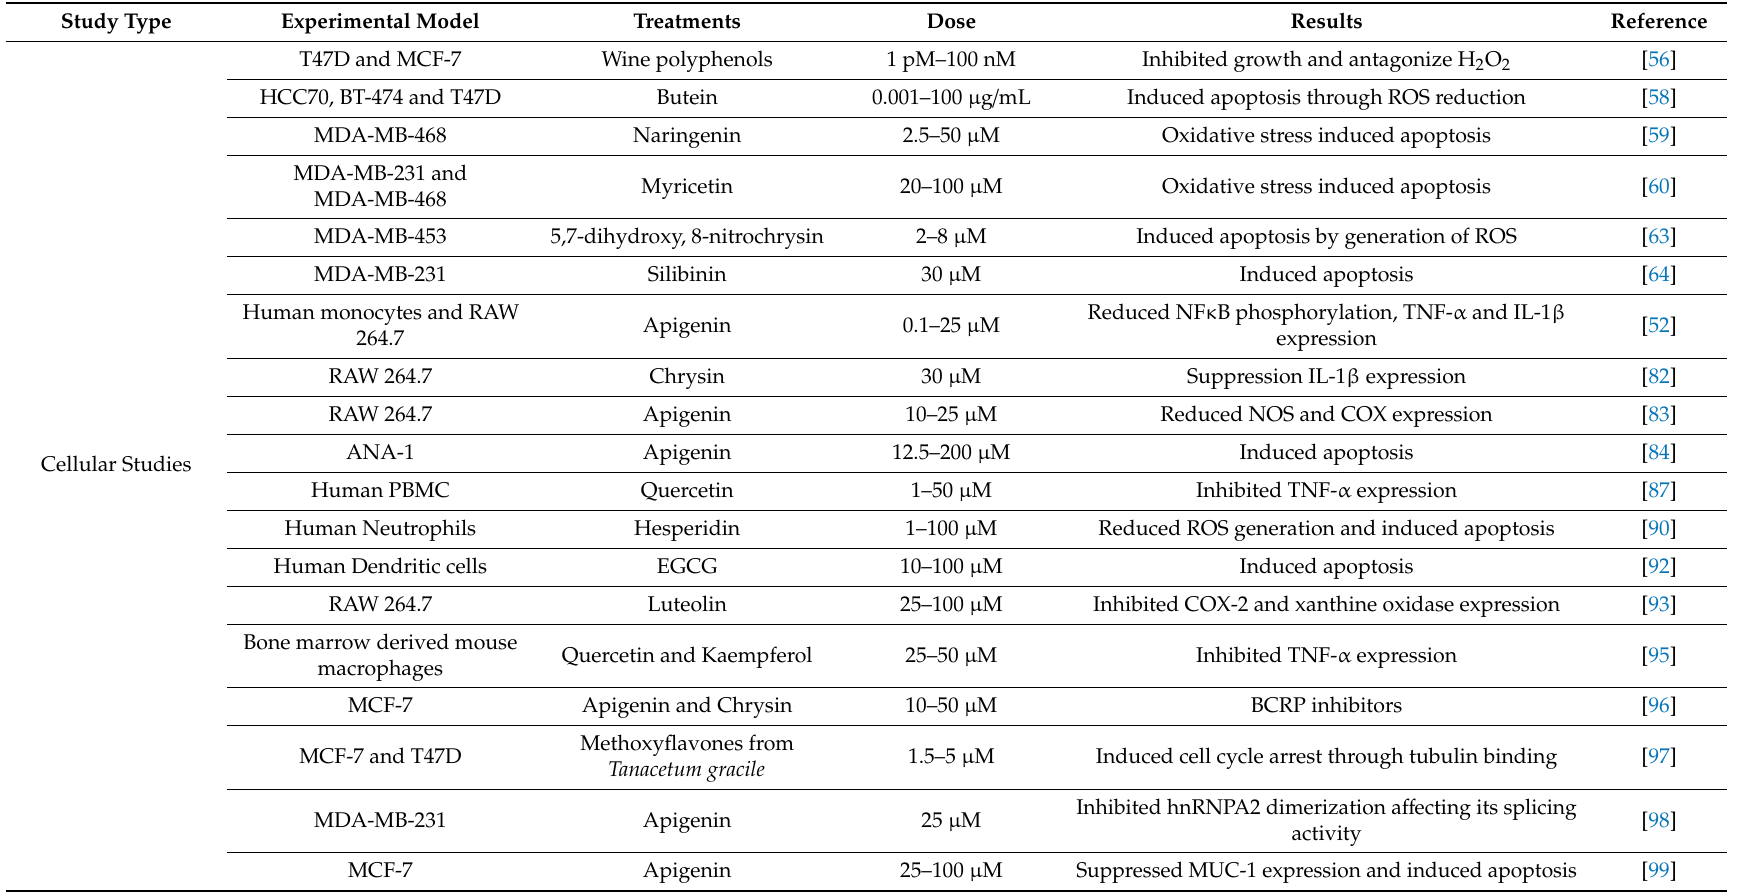
Table 2. Flavonoid doses in di ff erent experimental